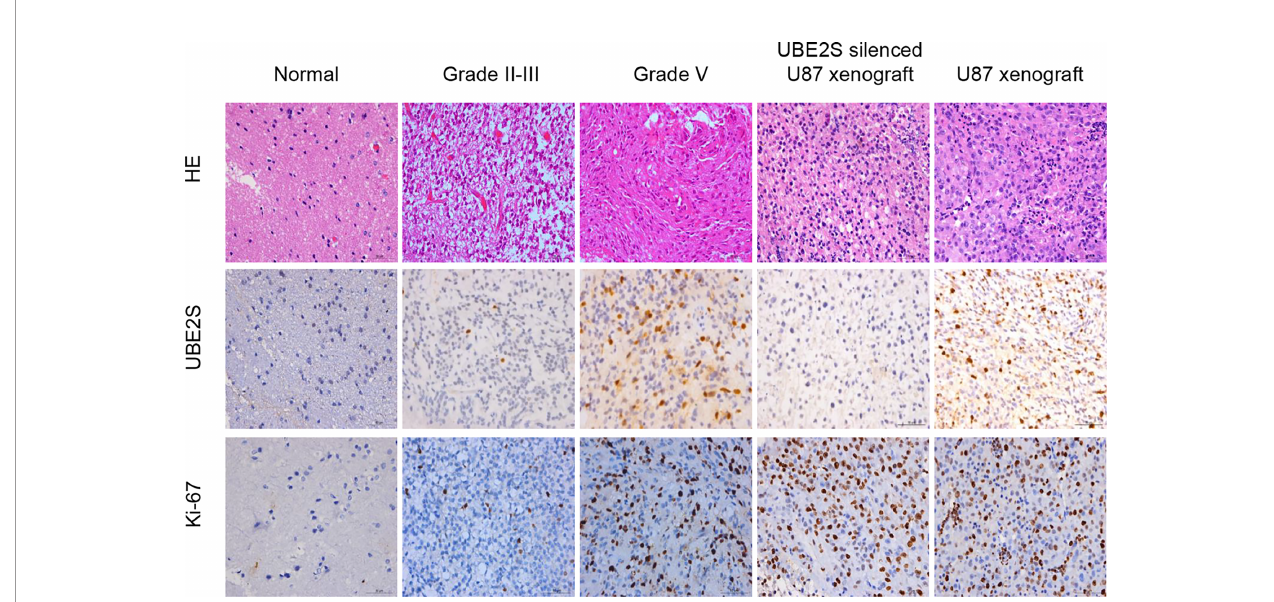
FIGURE 4 | UBE2S was highly expressed in glioma tissue specimens. Representative images of hematoxylin/eosin (HE) staining showing UBE2S and Ki-67 immunoreactivity from the tissue. Tumor xenograft obtained from U87 cells was stained with anti-UBE2S monoclonal antibody and used as positive control (PC). Normal tissue and tumor xenograft from UBE2S-silenced U87 cells were stained with anti-UBE2S monoclonal antibody and used as negative control (NC) (×400). Scale bar: 50 m m.